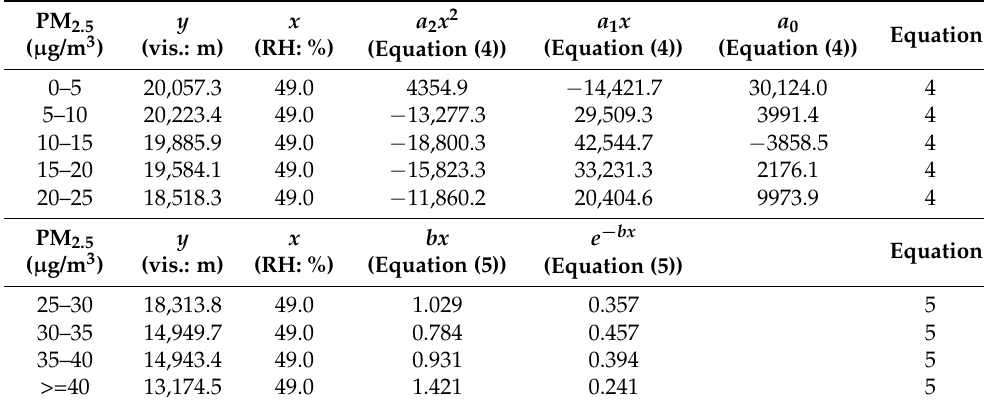
Table 3. Estimation of the negative relationship between visibility (m) and PM 2.5 concentrations ( µ g/m 3 ) as RH was adjusted within a certain